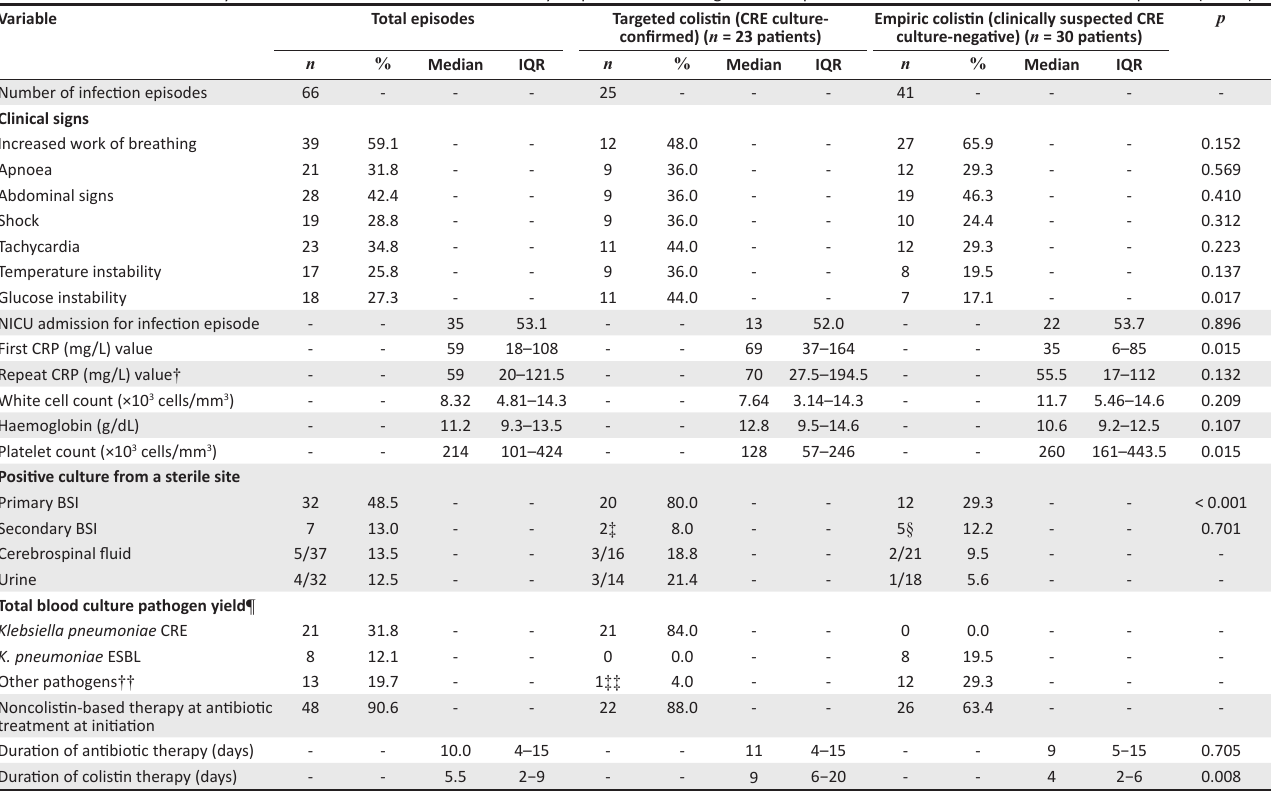
TABLE 2: Clinical and laboratory features of culture-confirmed and clinically suspected culture-negative carbapenem-resistant Enterobacterales infection episodes ( n = 66).